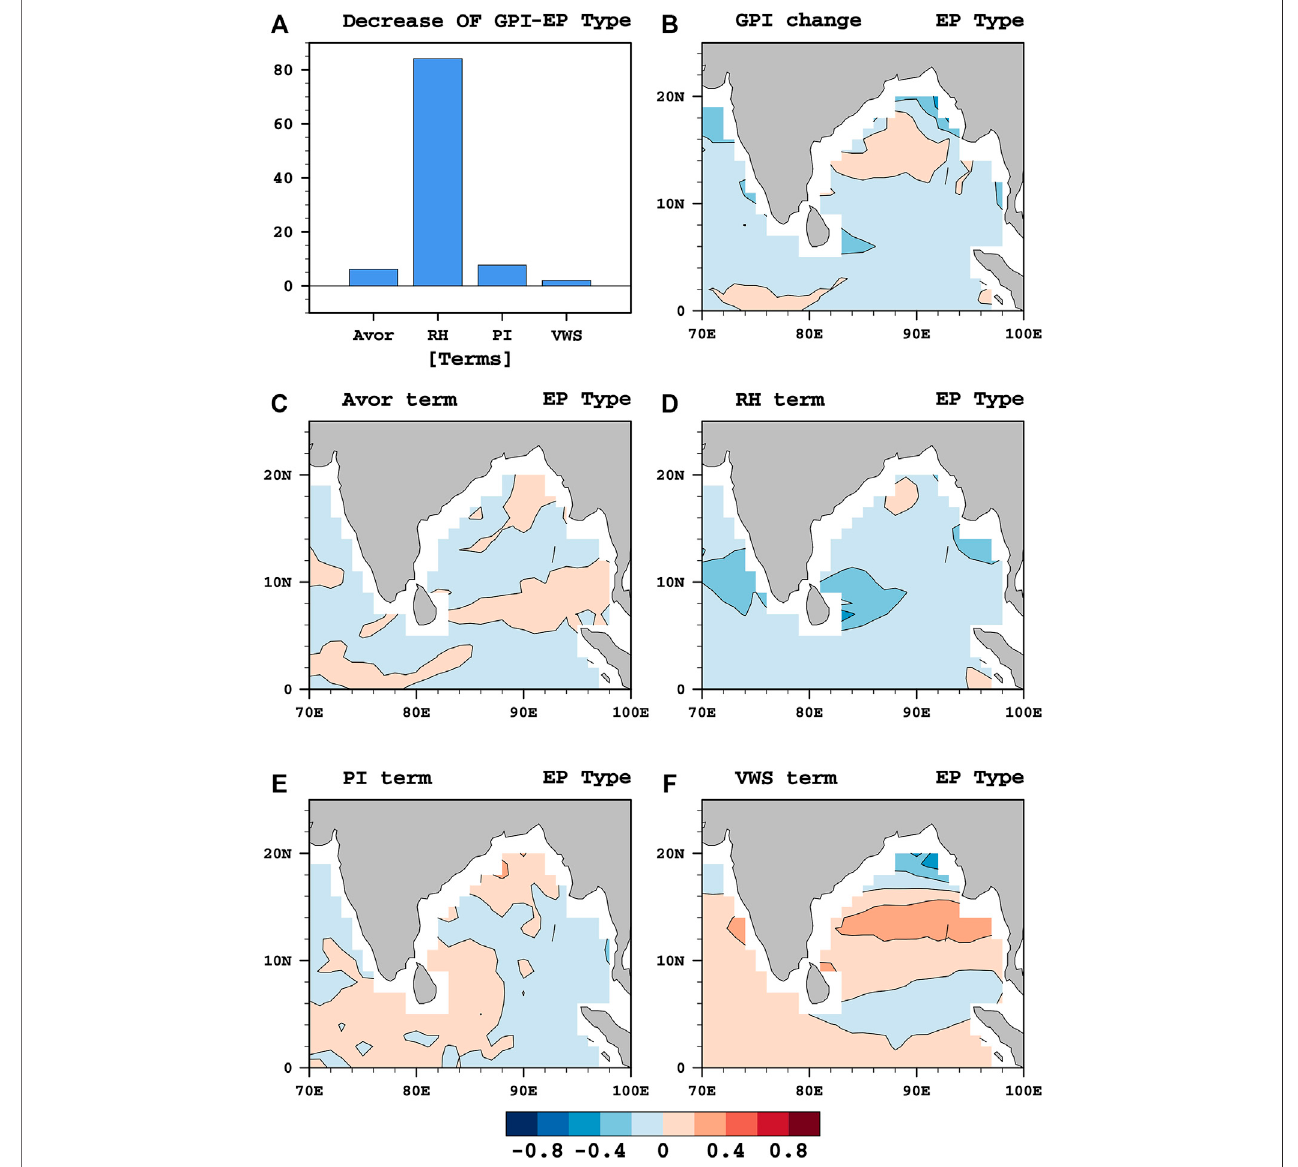
FIGURE 12 | (A) Relative contributions (percentages) of each term to the diagnosed GPI changes associated with EP El Niño during in AMJ over the southern boxed (blue box) (2 ° – 8 ° N, 80 ° – 98 ° E) region in Panel 11C . (B) The diagnosed GPI change and the spatial distribution of diagnosed four large-scale terms; (C) absolute vorticity at 850 hPa (Avor), (D) relative humidity at 700 hPa (RH), (E) potential intensity (PI), and (F) vertical wind shear (VWS).